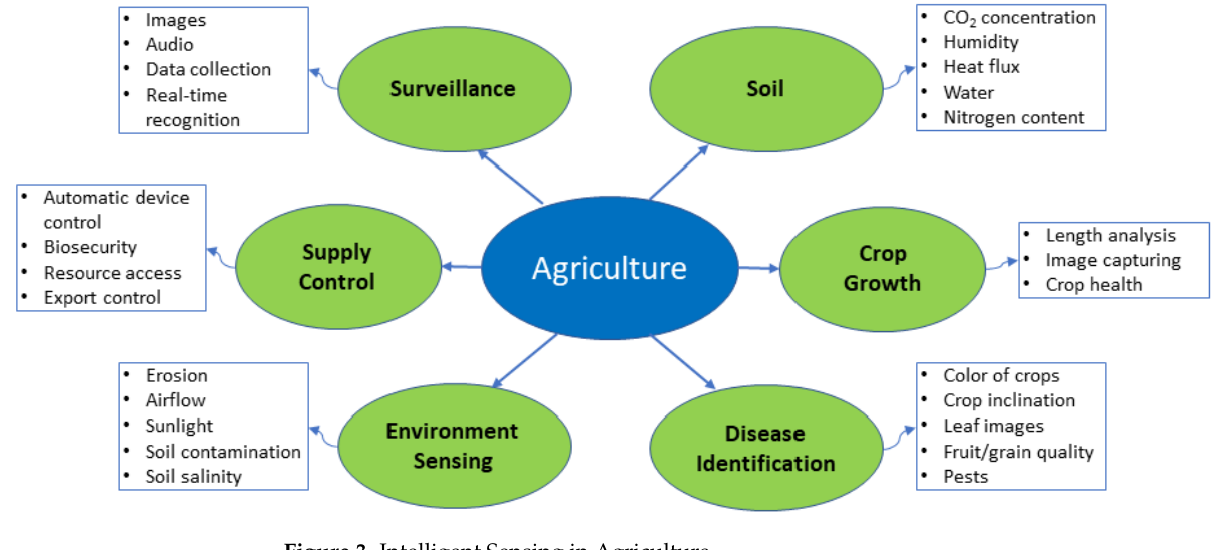
Figure 3. Intelligent Sensing in Agriculture.